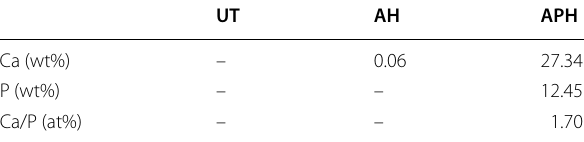
Table 1 Analysis results of Ca and P concentrations on the surfaces of Ti–6Al–4V ELI alloy plate specimens of the UT, AH, and APH groups immersed in SBF for 1 day